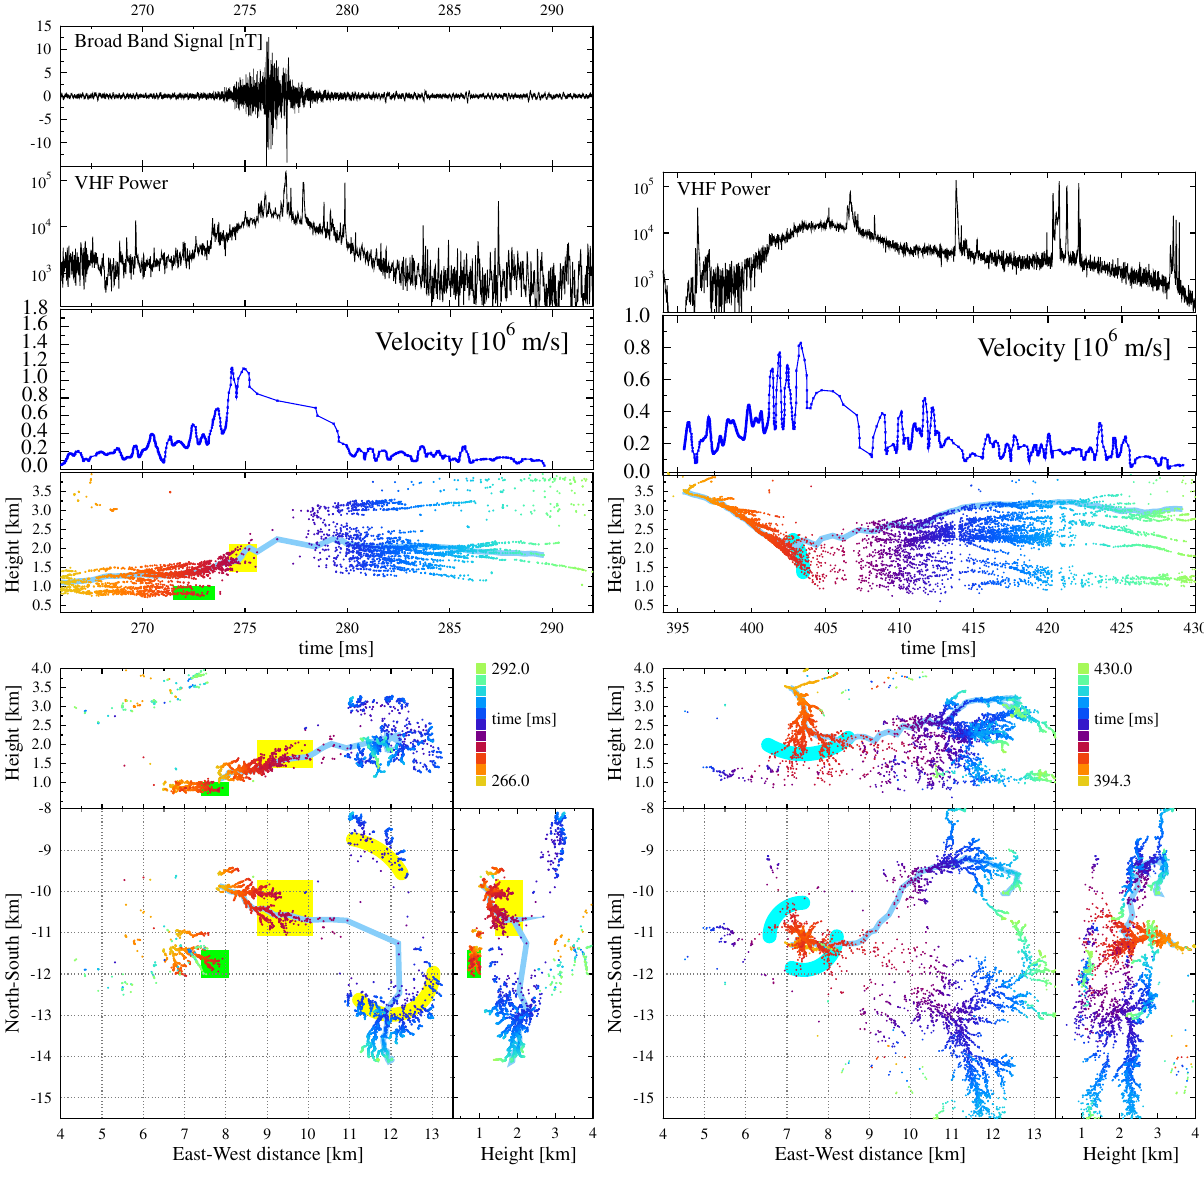
Figure 5. Same as Fig. 3 where the left shows a zoom-in for Flash B at the section where strong signals were measured in the broadband antenna, shown in the top panel, near t = 276 ms. The right side shows the time span of 395–430 ms of the same flash at the same location. For the later time there are no broadband data available. The scales for the left and right pictures are the same except for the time The right half of Fig. 5 shows the same area some 130 ms later during the same flash. For this period there are no data available from the broadband antenna. Figure 5 shows a negative leader propagating straight downward from the negative charge layer at 4 km into the positive charge layer at and below 2 km altitude. This occurred at the same location, projected on the ground plane, as where the first negative leader on the left side of the figure stalled. At t = 403 ms the structure of the imaged leader changes, as indicated by the cyan colors, to a structure reminiscent of that of an IRNL. 5 ms later, at a distance of about 4 km, normal negative leaders are imaged again, 10 5 m/s. The northern branch (which is followed for making the velocity plot) amounting to a speed of 8 × propagates slightly slower. The VHF power shows a strong increase when the negative leader was propagating downward from 3.5 km height. There are no separate surges in VHF power visible to indicate stepping, which might be due to the fact that there were several IRNL branches active at the same time. Unfortunately there is no broadband time trace available for this time period so the stepping nature could not be confirmed. The lack of broadband data not withstanding, the picture shows another typical example of an IRNL. As discussed above, the VHF power shows strong spikes on top of the broader emission from the IRNL in Fig. 5. At first glance, the source of these sharp spikes is unclear and they could be indicative of some IRNL